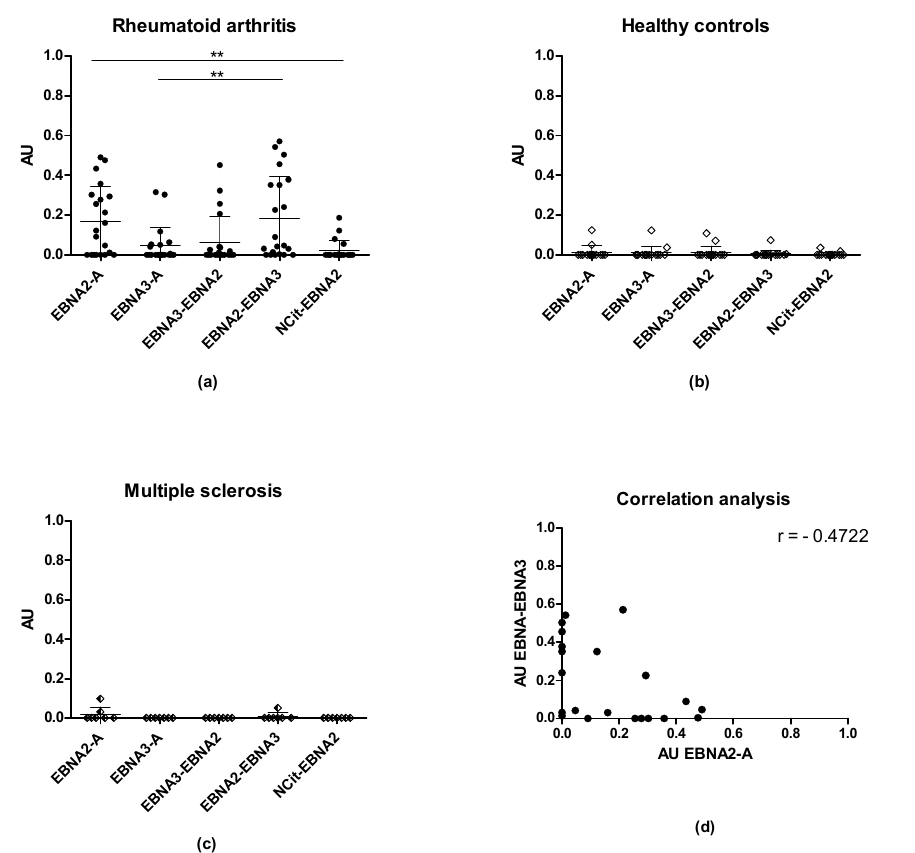
Figure 2. Reactivity of rheumatoid arthritis (RA) sera, multiple sclerosis (MS) sera and healthy control (HC) sera to overcrossing and N-terminal citrullinated peptides analyzed by enzyme-linked immunosorbent assay: ( a ) reactivity of RA sera to citrullinated peptides; ( b ) reactivity of HC sera to citrullinated peptides; ( c ) reactivity of MS sera to overcrossing peptides; ( d ) correlation analysis of RA antibody reactivity between EBNA2-A and EBNA2-EBNA3. ** = p <